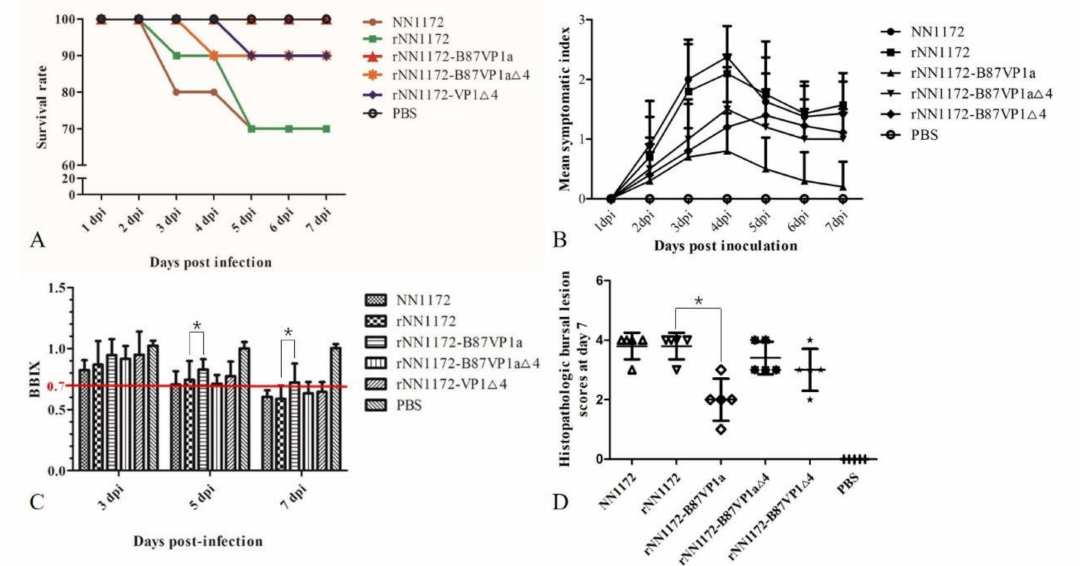
Figure 2. Characteristics of Three-Yellow chickens infected by the rescued virus. ( A ) Percent survival of chickens on different days post-challenge with the recombinant viruses. ( B ) Mean symptomatic index during 1–7 dpi in chickens challenged with mosaic recombinant viruses. ( C ) The bursa/body weight index (BBIX) of chickens challenged with the mosaic recombinant viruses at 3, 5, and 7 dpi. ( D ) Histological bursal lesion scores (HBLS) of chickens challenged with the mosaic recombinant viruses at 7 dpi. * means significantly different ( p <